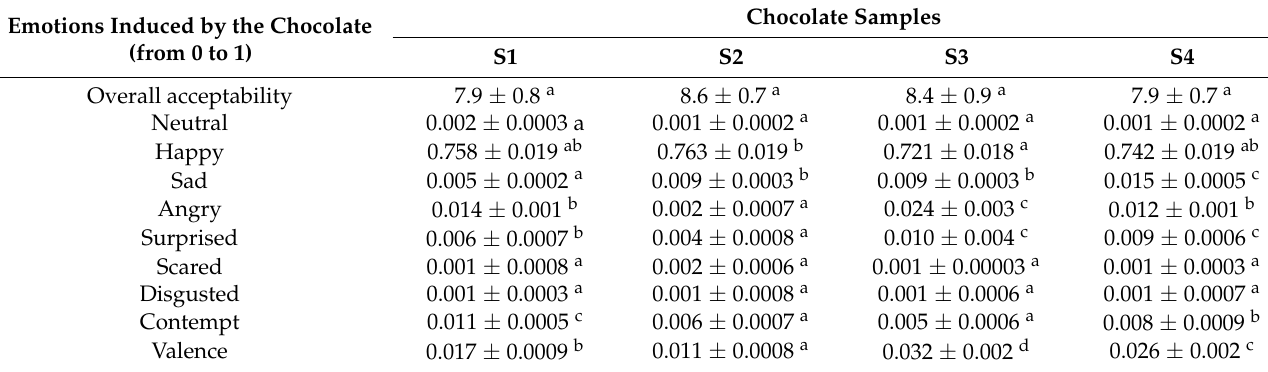
Table 1. Overall acceptability and emotion response of the dark chocolate